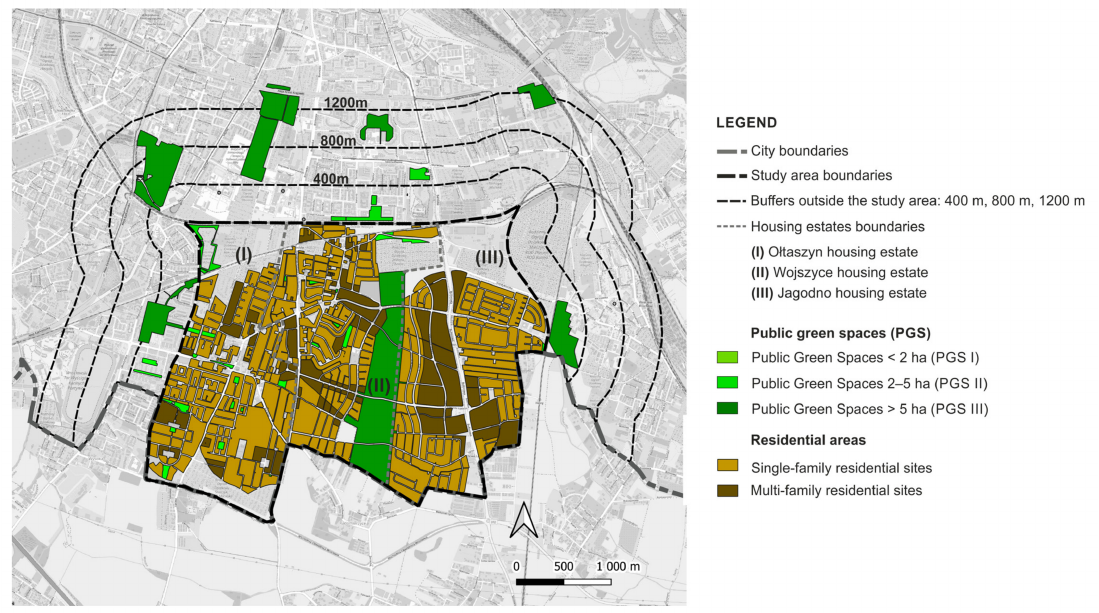
Figure 9. Layout of residential sites and PGS according to land use